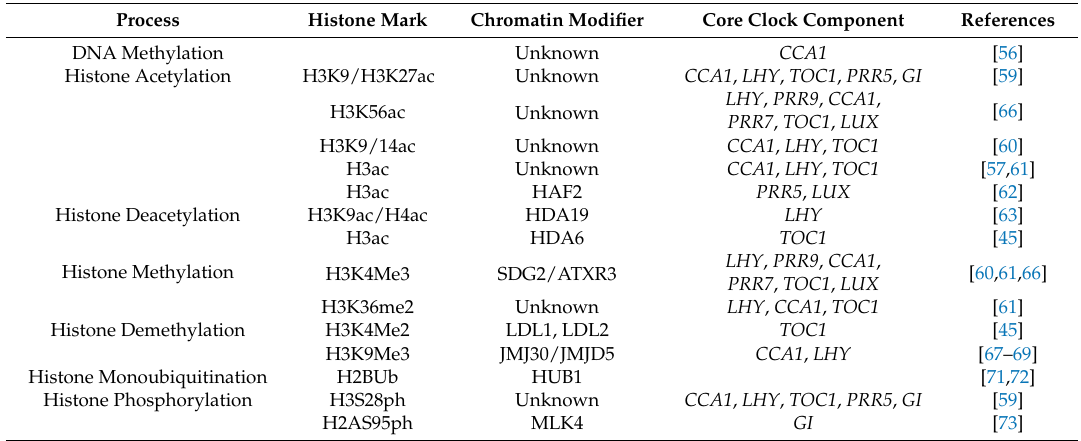
Table 1. Regulation of the core circadian clock genes by chromatin modifications in Arabidopsis